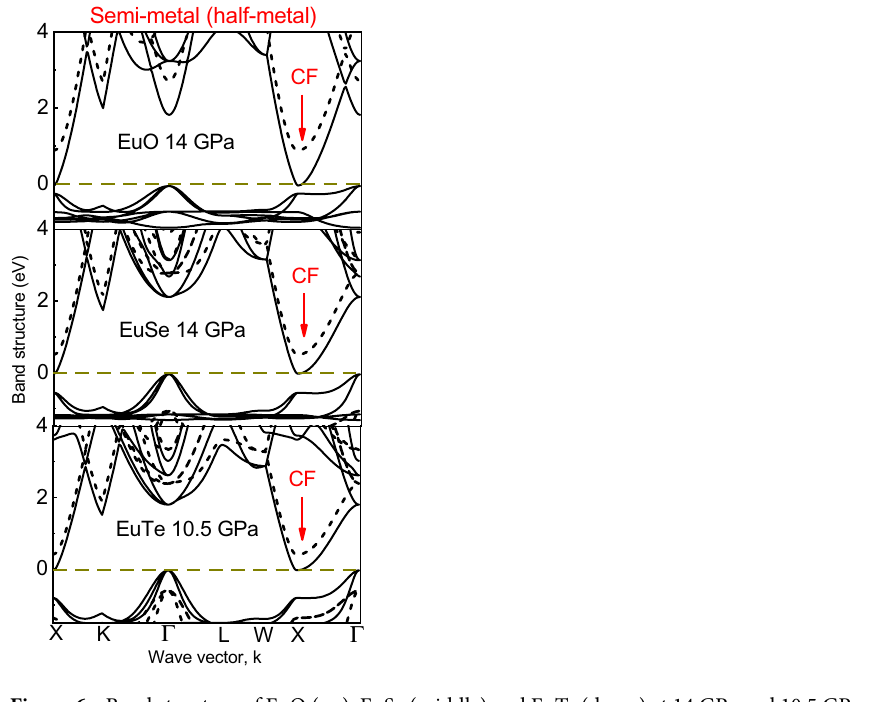
p-DOS matches suitably with the experimental one (Fig. 4c). The progressive electron delocalization of the 4 f states with pressure is evidenced through their p-DOS (Fig. 5e, up). The top of VB shifts towards higher energy whereas the lower VB decreases in energy yielding a broadening of the Eu 4 f states. It must be noted that as the delocalization of the 4 f states evolves, there is an